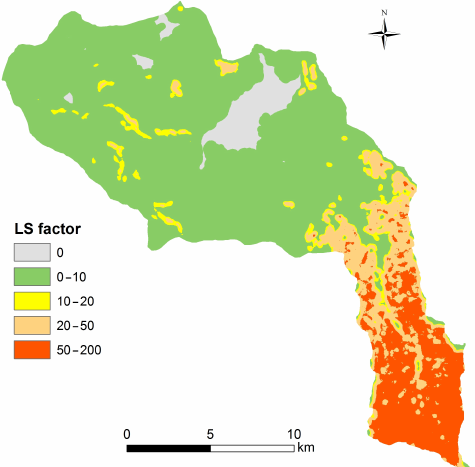
Figure 5. Map of slope length and steepness (LS) factor generated from the DEM and topographic map of the study site.